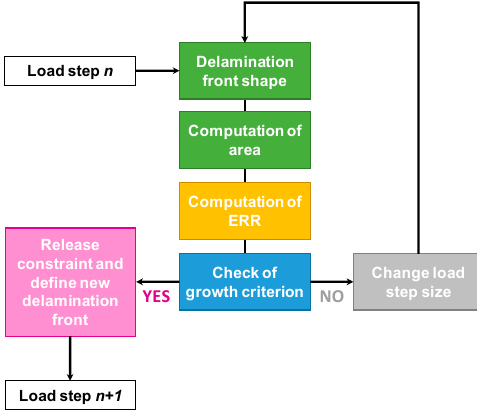
Figure 1. Smart-time XB (SMXB) flow chart.